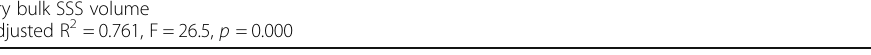
Table 6 Dry bulk SSS model